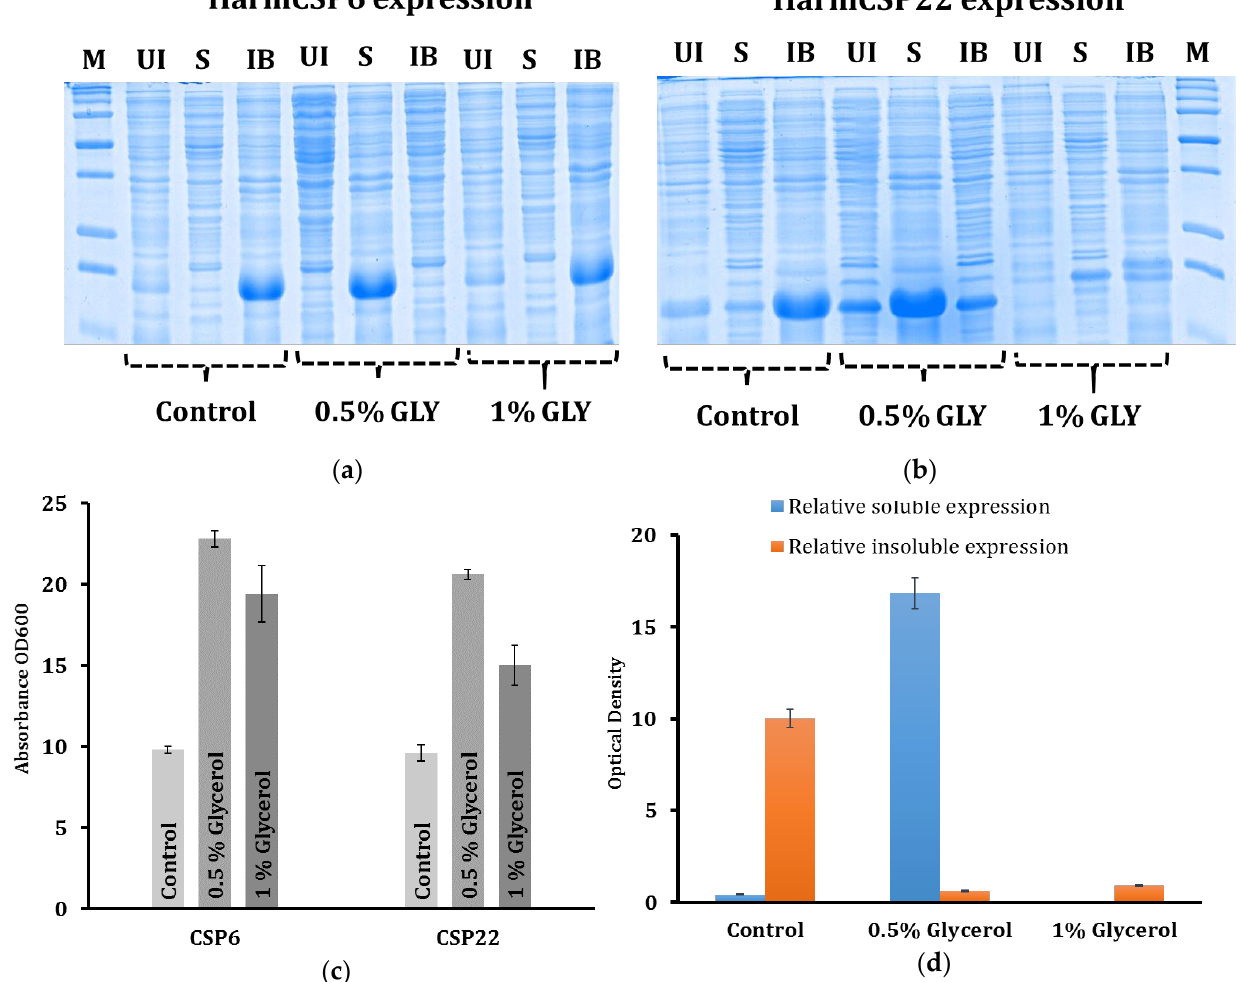
Figure 4. In vitro expression study of HarmCSP6 and HarmCSP22 using bacterial host. ( a , b ) SDS-PAGE gel images showing expression levels of HarmCSP6 and 22 in BL21-DE3 E. coli cells, respectively. UI—uninduced cells, IB—inclusion bodies, S—supernatant, control (M16 + 0% glycerol), 0.5% GLY (M16 + 0.5% glycerol), and 1% GLY (M16 + 1% glycerol). ( c ) Chart showing levels of absorbance at 600 nm of bacterial cell culture expressing HarmCSP6 and 22 in M16 media with 0%, 0.5%, or 1% glycerol. ( d ) Densiometric quantification of protein band showing relative soluble or insoluble expression of HarmCSP6 and 22 in M16 media with 0%, 0.5%, or 1%